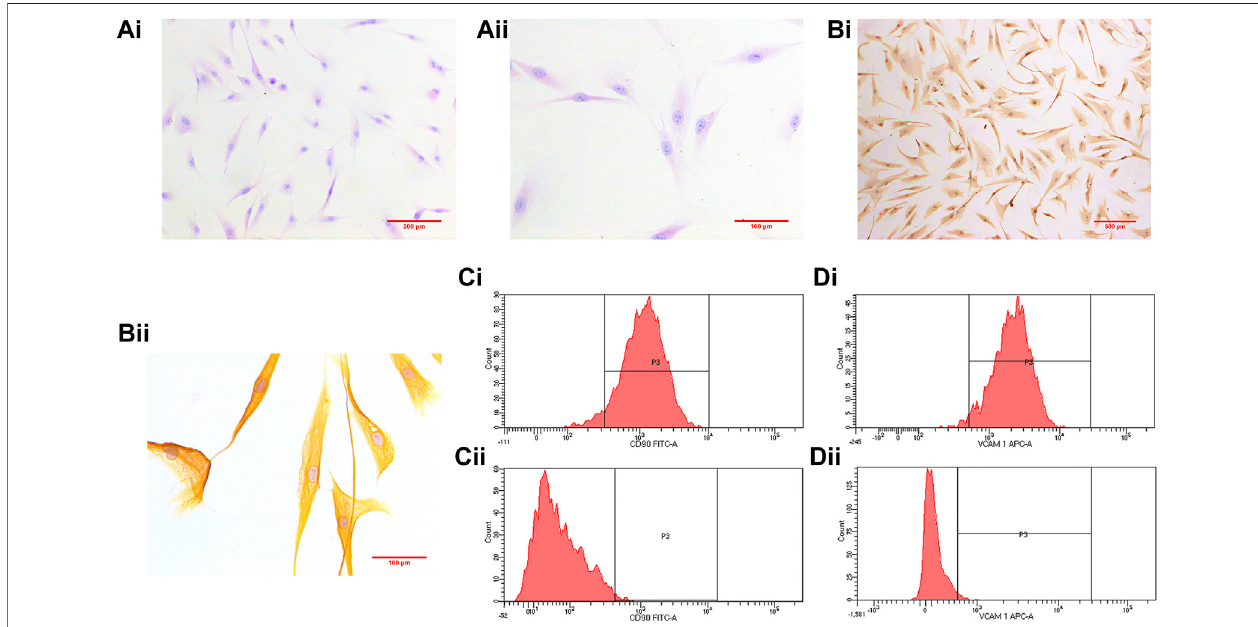
FIGURE4| [ (A) ,i]( × 100)and[ (A) ,ii]( × 200)showHEstainingresults.Immunohistochemistryresultsareshownin[ (B) ,i]( × 100)and[ (B) ,ii]( × 400).[ (C) ,i]showsthe purityoftheisolationcellsmarkedwithFIDCanti-CD90(96.6 ± 1.44%; n (cid:2) 4),and[ (C) ,ii]representscontrol[ (D) ,i]showsthepurityoftheisolationcellsmarkedwithAPC anti-VCAM-1 (97.1 ± 0.39%; n (cid:2) 4), and [ (D) , ii] represents